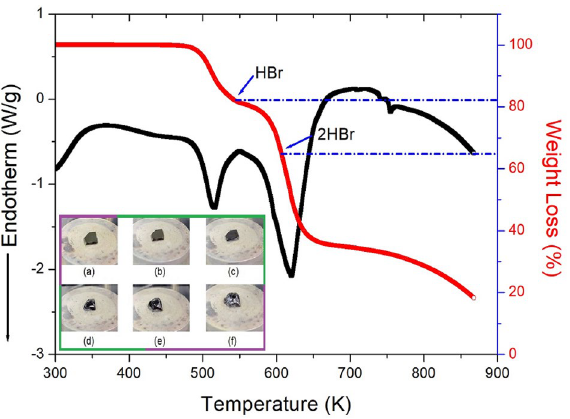
Figure 2. Thermogravimetric analysis (TGA) and differential thermal analysis (DTA) curves of [NH 3 (CH 2 ) 3 NH 3 ]CuBr 4 (inset: Changes in crystal measured by optical polarizing microscopy at ( a ) 300, ( b ) 453, ( c ) 500, ( d ) 543, ( e ) 593, and ( f ) 621